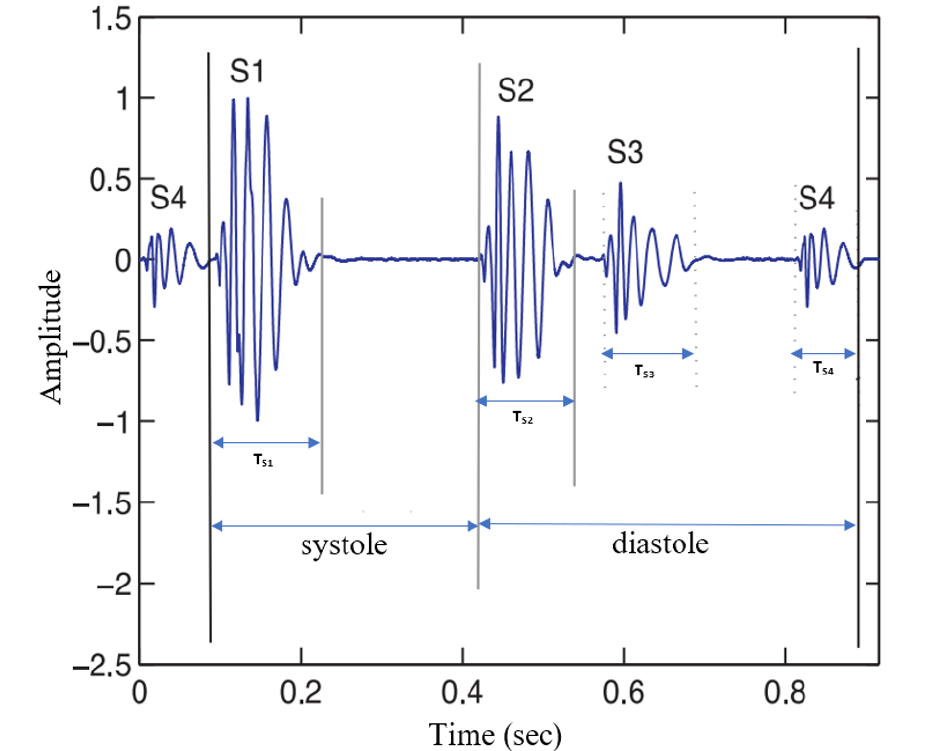
Figure 1. Typical waveform of a phonocardiogram (PCG) signal and its components: S 1 ( T S 1 = 70–150 ms), S 2 ( T S 2 = 60–120 ms), S 3 ( T S 3 = 40–100 ms), and S 4 ( T S 4 = 40–80